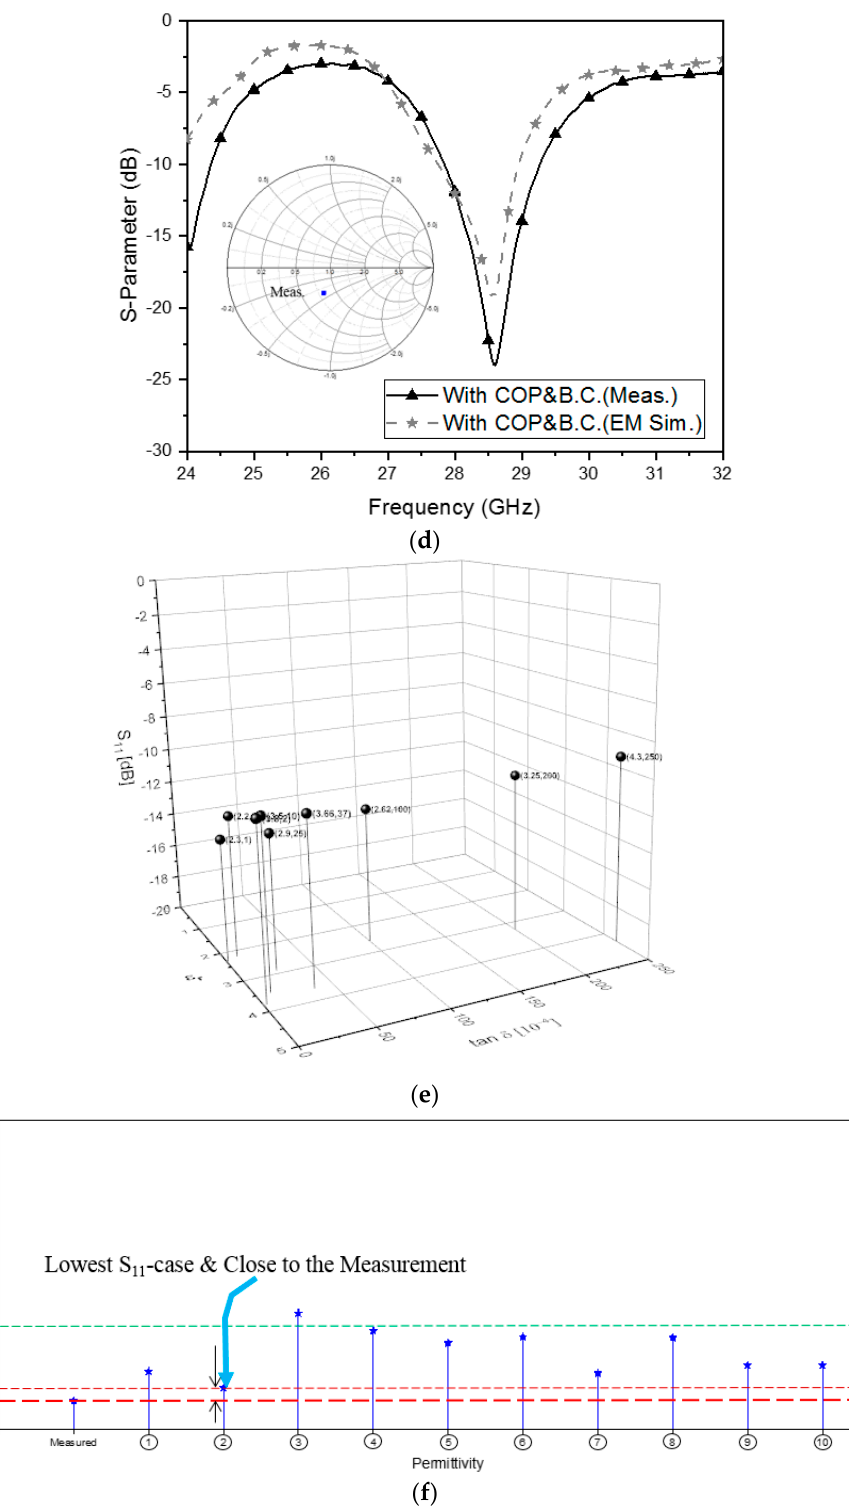
Figure 9. Physical realization of the proposed sensor and frequency responses. ( a ) The sensor before and after placing the meta-surface patterned COP film. ( b ) Proposed sensor attached to the back-cover. ( c ) S 11 of the back-cover with the COP film. ( d ) S 11 of the back-cover with the meta-surface COP film. ( e ) S 11 of various choices in the permittivity plane. ( f ) S 11 of various choices of permittivity.